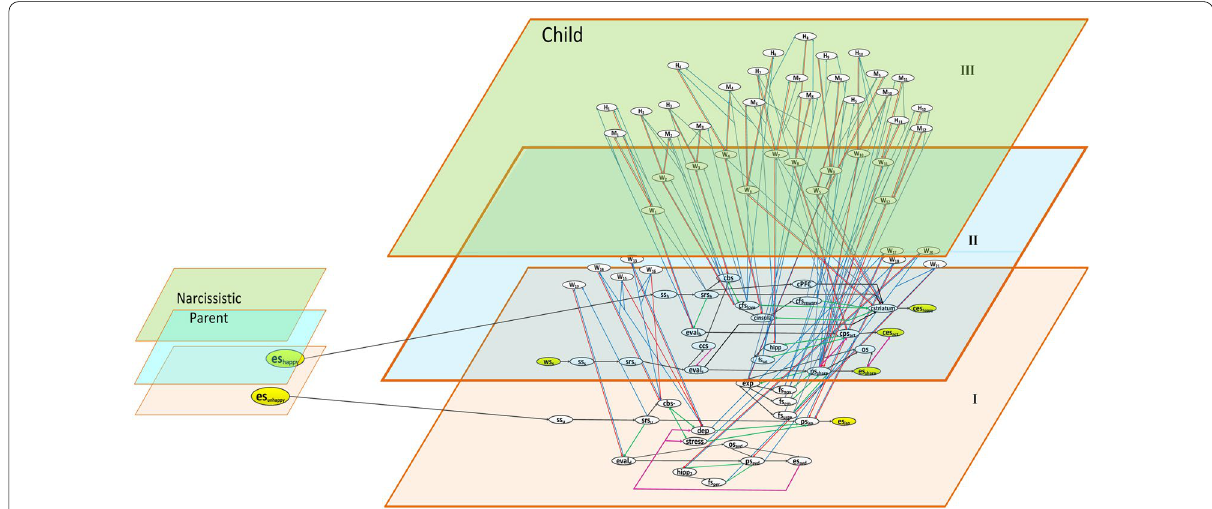
Fig. 2 Second-order reified network model of a child under the influence of a